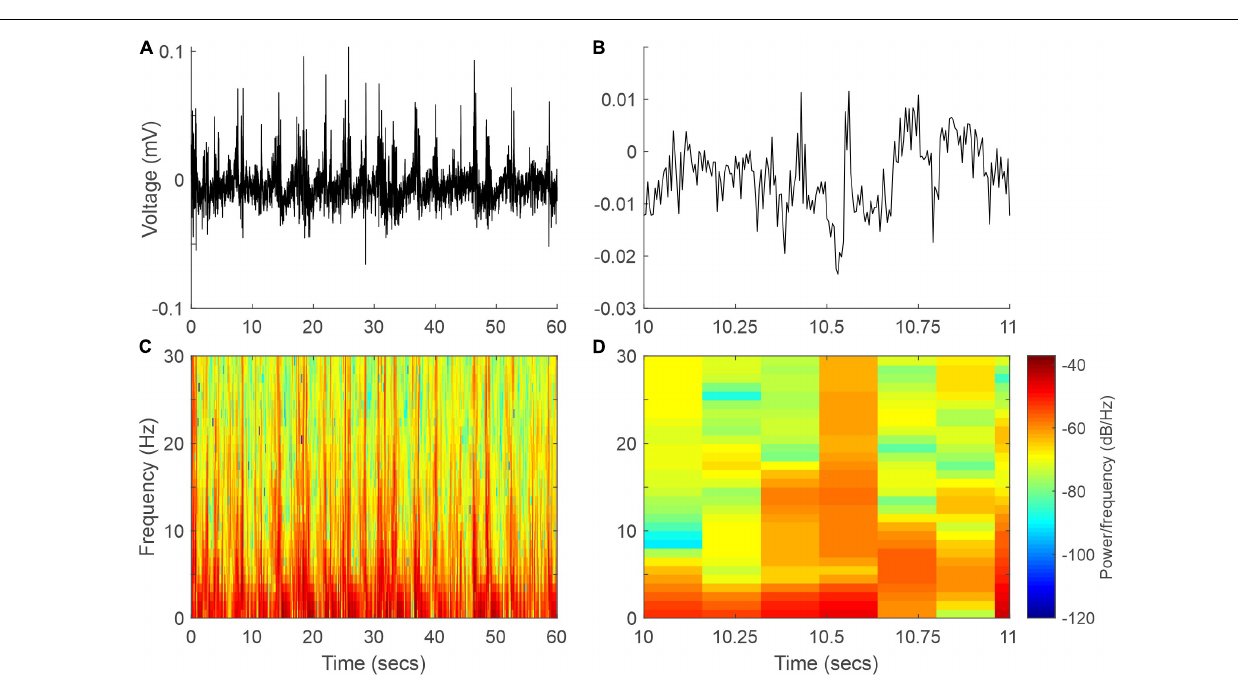
FIGURE 2 | Example EEG signal and spectrogram at 37 ◦ C. (A) Sixty-second segment of the EEG signal. (B) One-second recording expanded from panel (A) . (C,D) Spectrograms of the EEG signals in panels (A,B) ,